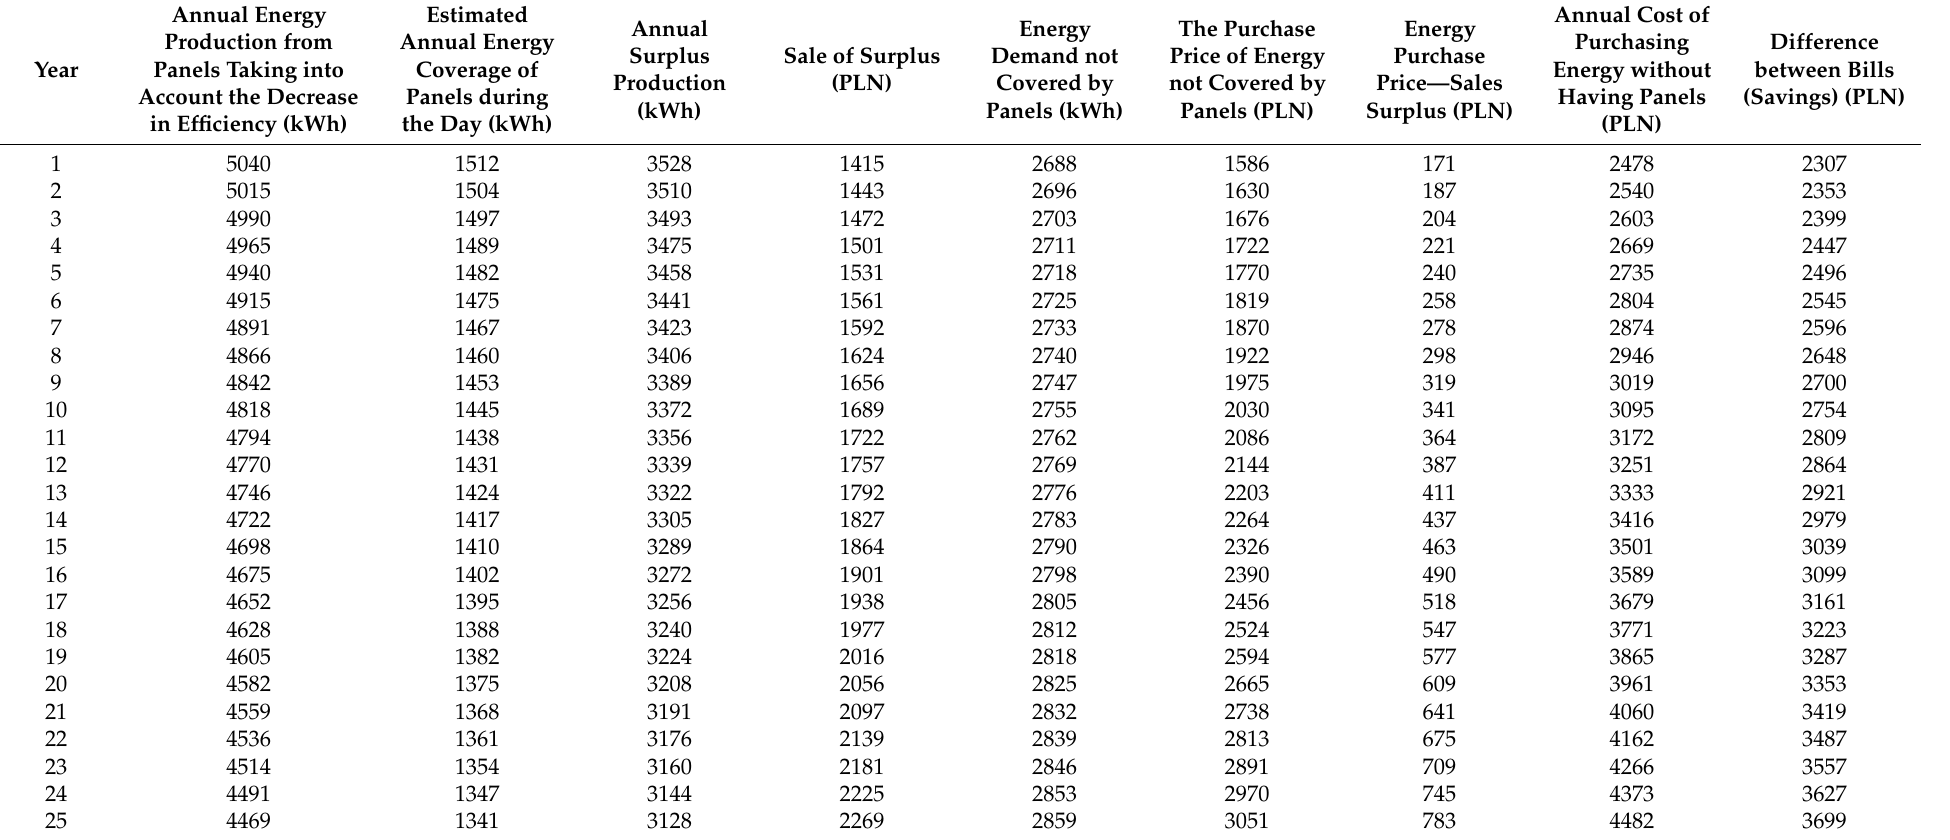
Table A3. The energy settlement with the net-billing